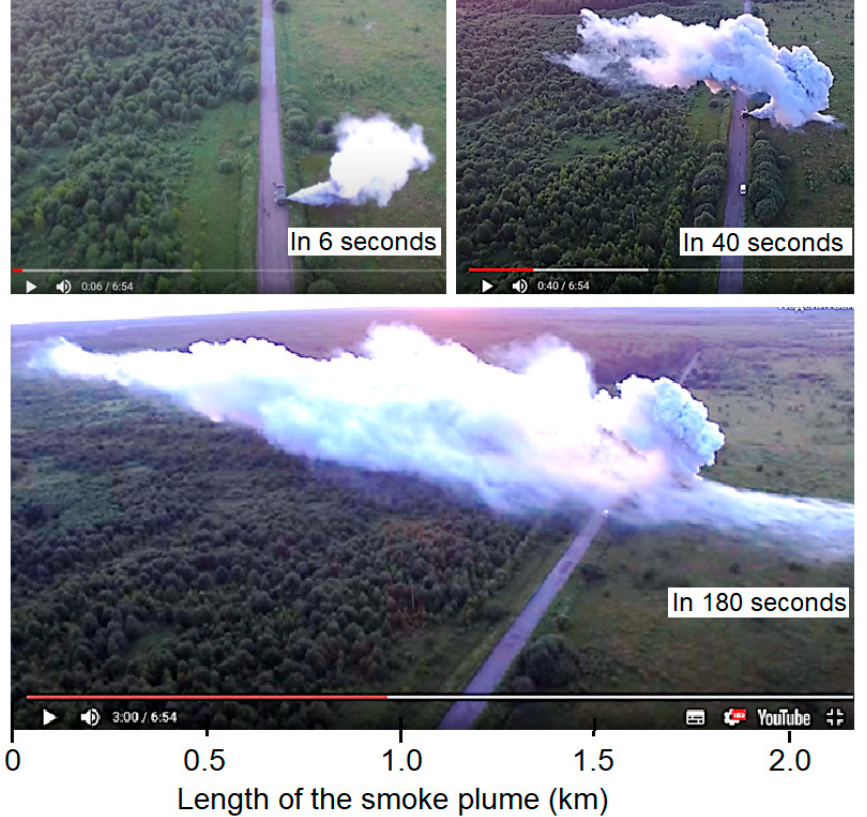
Figure 15. Aerosol plume created by the TDA-3 smoke machine during 6, 40 and 180 s from the start of the operation. Used with permission from “NPP Inprokom” Ltd.